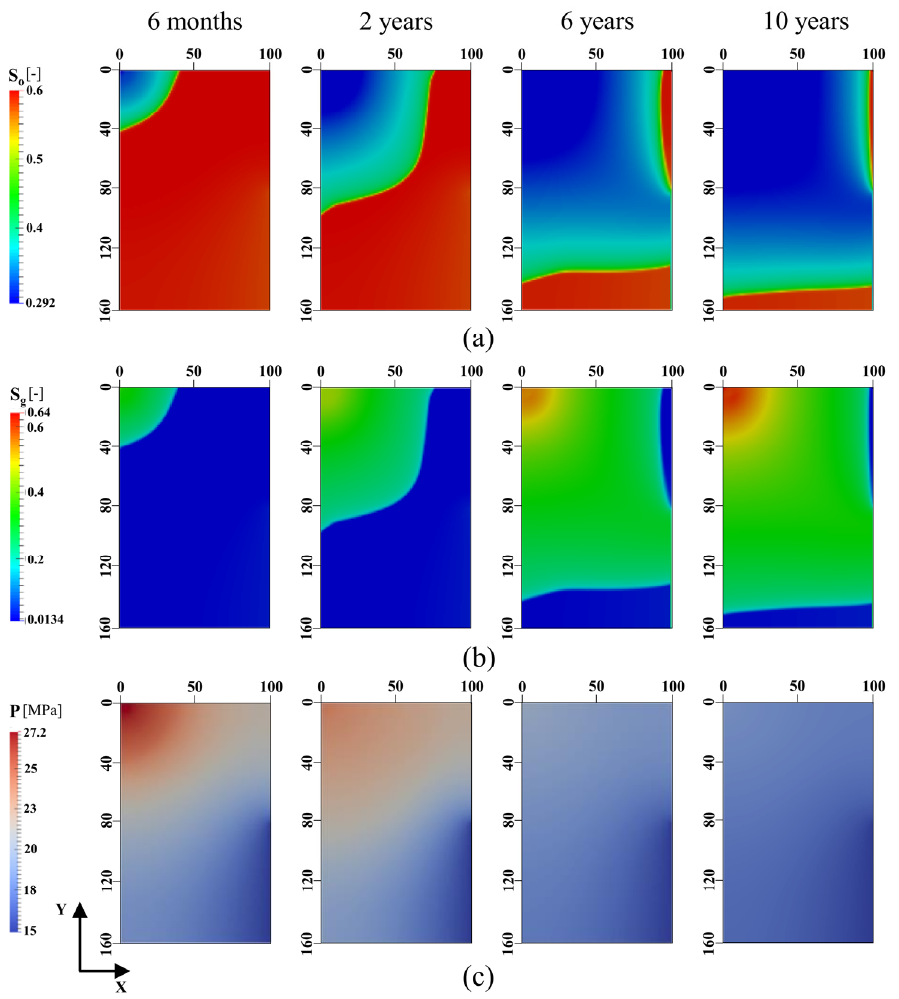
Figure 6. Saturation and reservoir pressure variations in the homogeneous model ( a ) Distribution of gas saturation at the 6th month, 2nd, 6th, and 10th year; ( b ) Distribution of oil saturation at the 6th month, 2nd, 6th, and 10th year; ( c ) Distribution of reservoir pressure at the 6th month, 2nd, 6th, and 10th year.